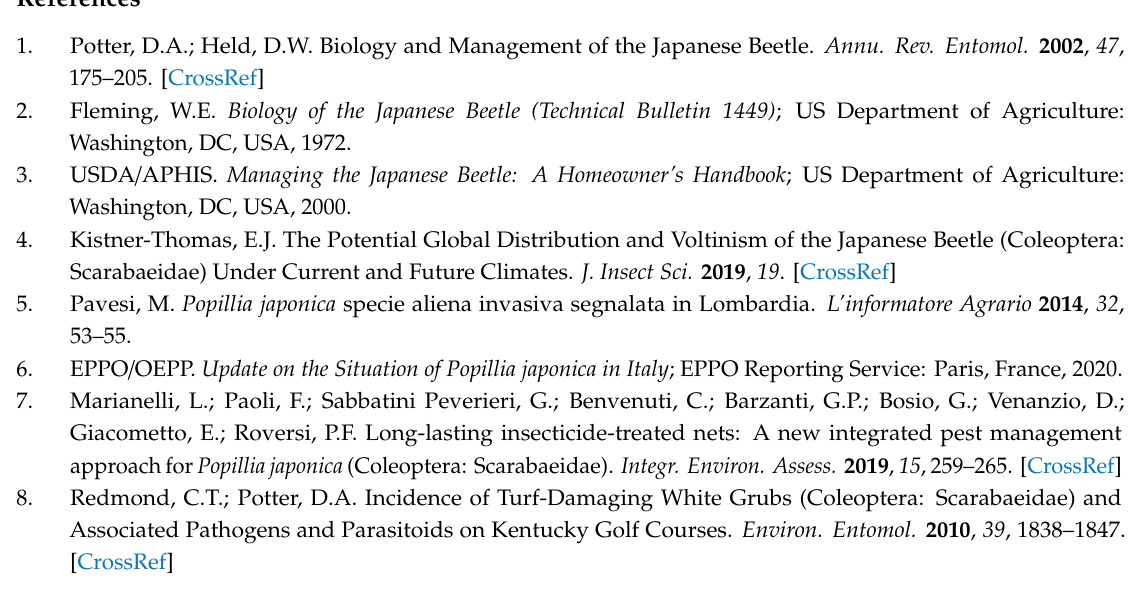
Table S1: Morphometric characters of entomopathogenic nematode isolates, Figure S1: Maximum Likelihood phylogenetical reconstruction based on ITS